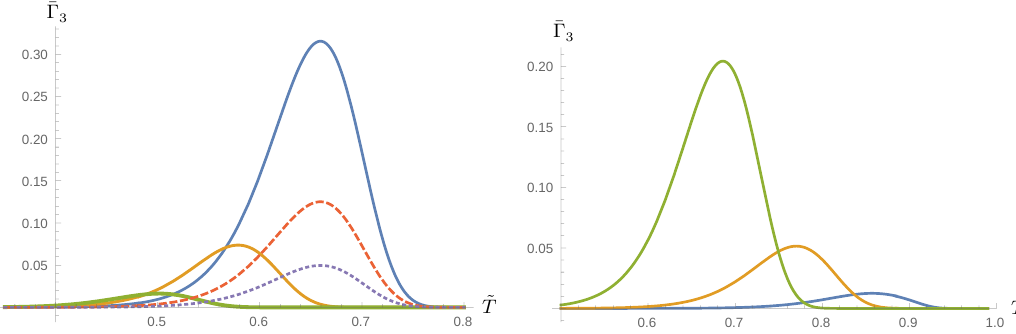
Figure 12 . Plots of ¯Γ 3 ≡ Γ 3 /M 4 for different values of parameters. On the left, the rate KK magnitude is quenched as N is increased (solid blue, dashed and dotted lines correspond to N = 10 , 20 , 40 with λ = 10 , ¯ f χ = 10 ) and as λ is increased (solid blue, orange, green lines correspond to λ = 10 , 20 , 40 with N = 10 , ¯ f χ = 10 ). On the right, the magnitude increases as ¯ f χ is increased (blue, orange and green lines correspond to ¯ f χ = 2 , 4 , 8 with λ = 10 , N = 10